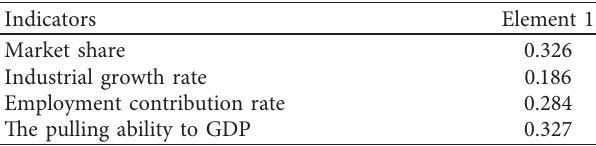
Table 12: Component score coefficient